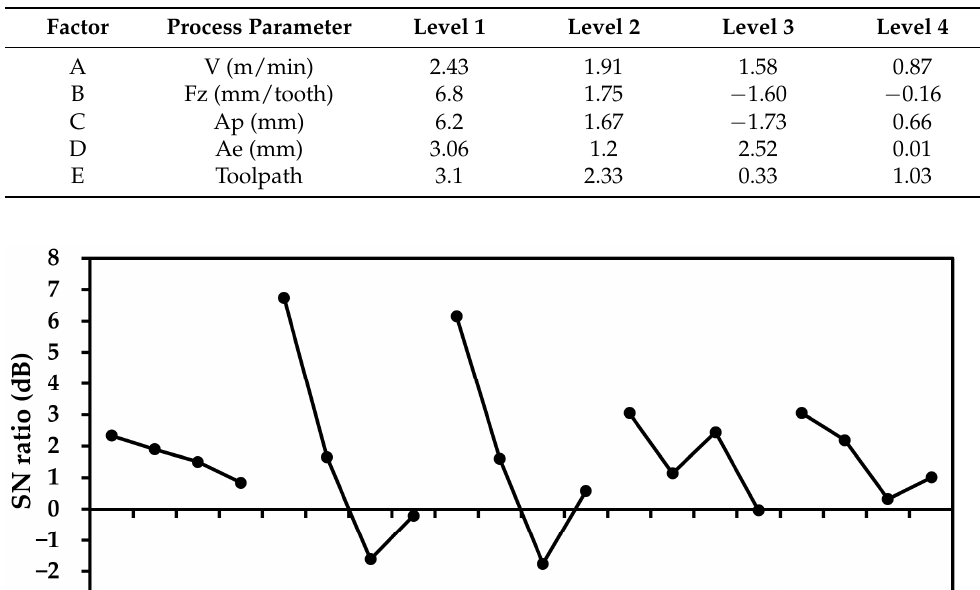
Table 7. SN ratio values for surface roughness.